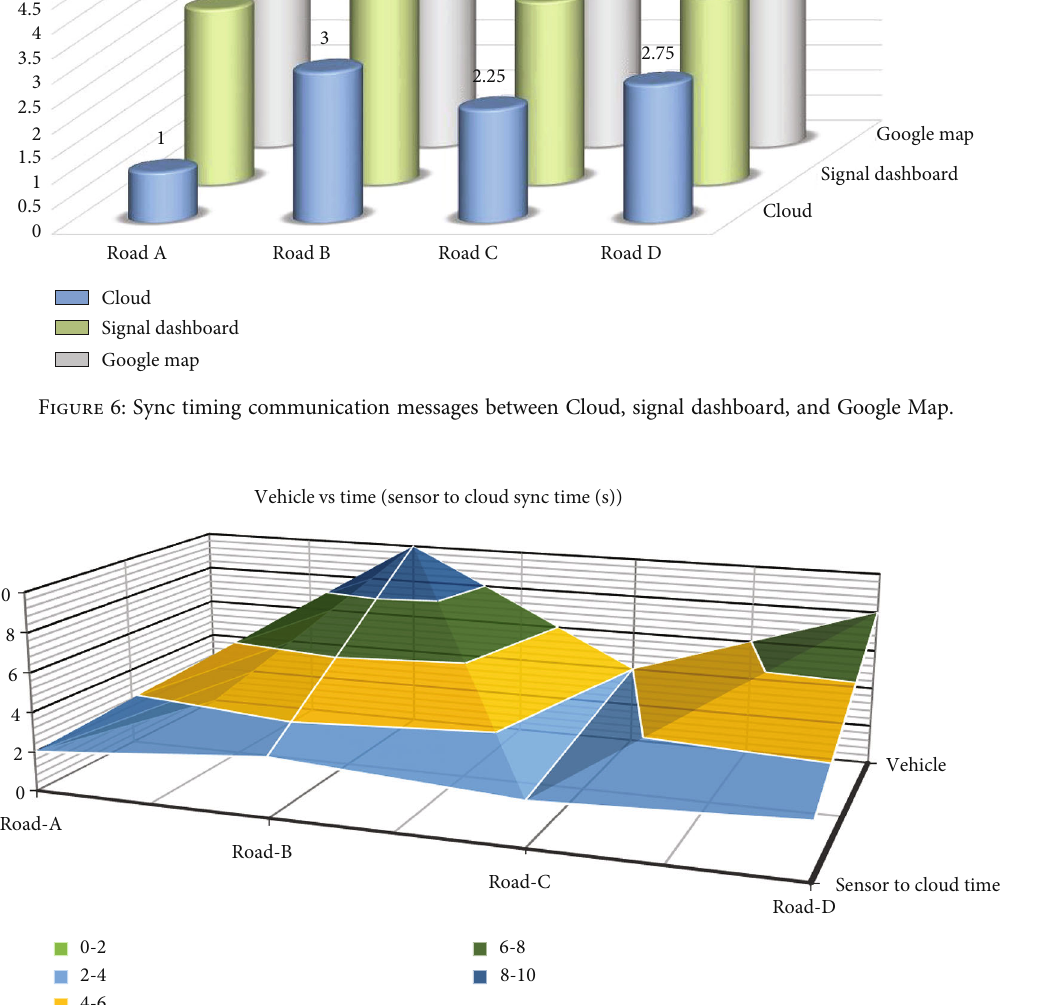
Sensor to cloud